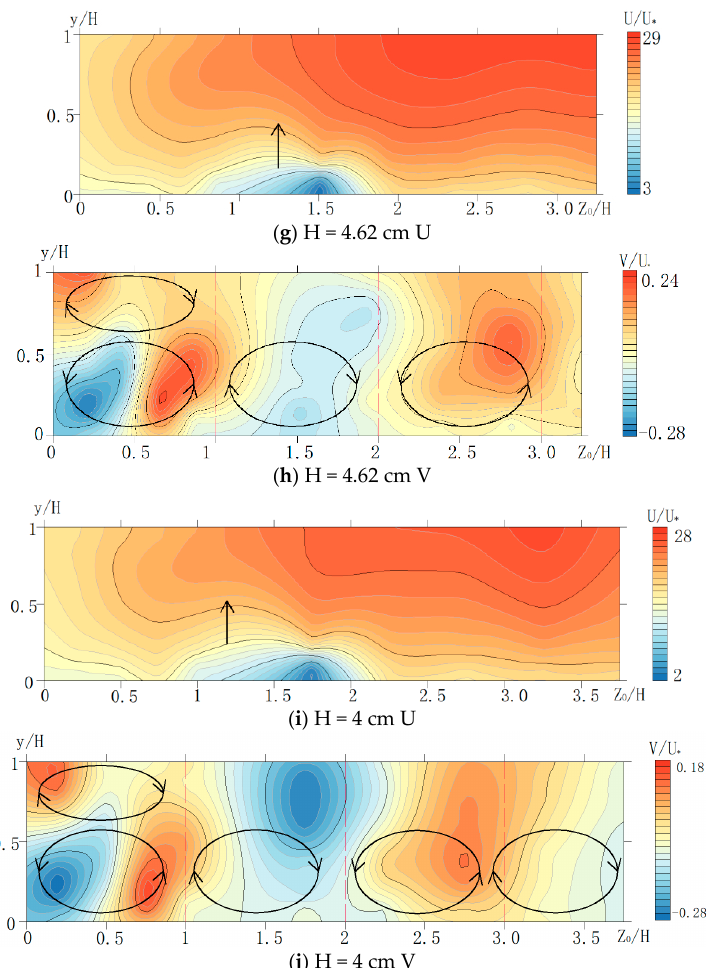
Figure 6. ( a ), ( c ), ( e ), ( g ), ( i ) Stream-wise velocity distribution for H = 10 cm, 8 cm, 6 cm, 4.62 cm, 4 cm; ( b ), ( d ), ( f ), ( h ), ( j ) vertical velocity distribution for H = 10 cm, 8 cm, 6 cm, 4.62 cm, 4 cm. On the basis of numerous experimental data, Wang [29] proposed Equation (1) to predict the relative position of the maximum velocity. The influence of relative distance from the side wall and aspect ratio is considered and used as the parameter Z 0 / H which decides the dip position.